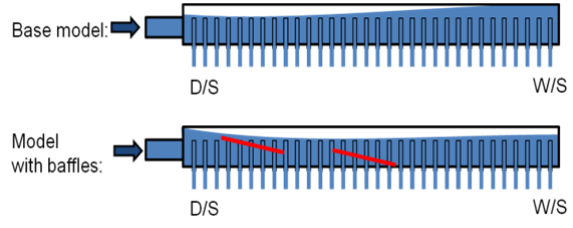
Figure 5. Schematic diagram of the base model and model with baffles.